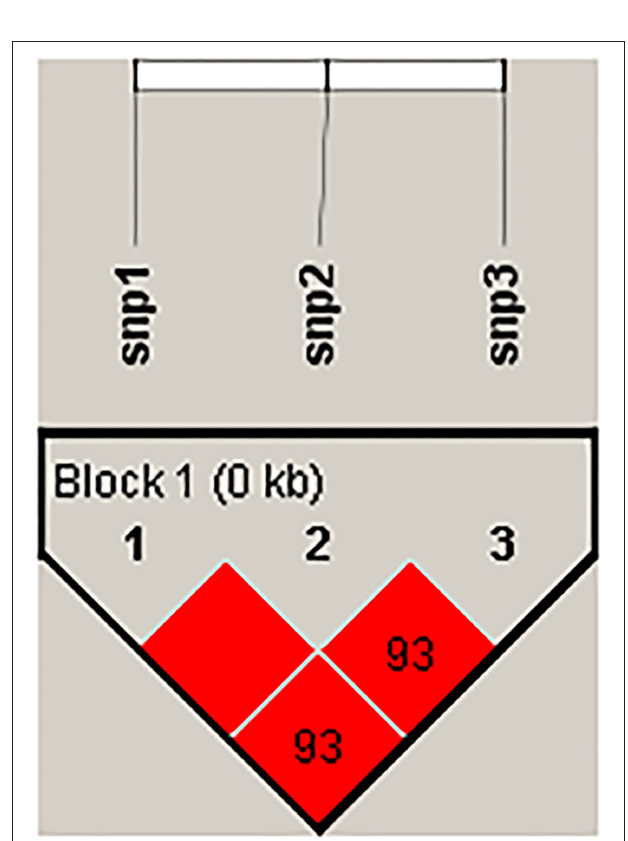
FIGURE 5 | Linkage disequilibrium analysis of three SNPs of IL18